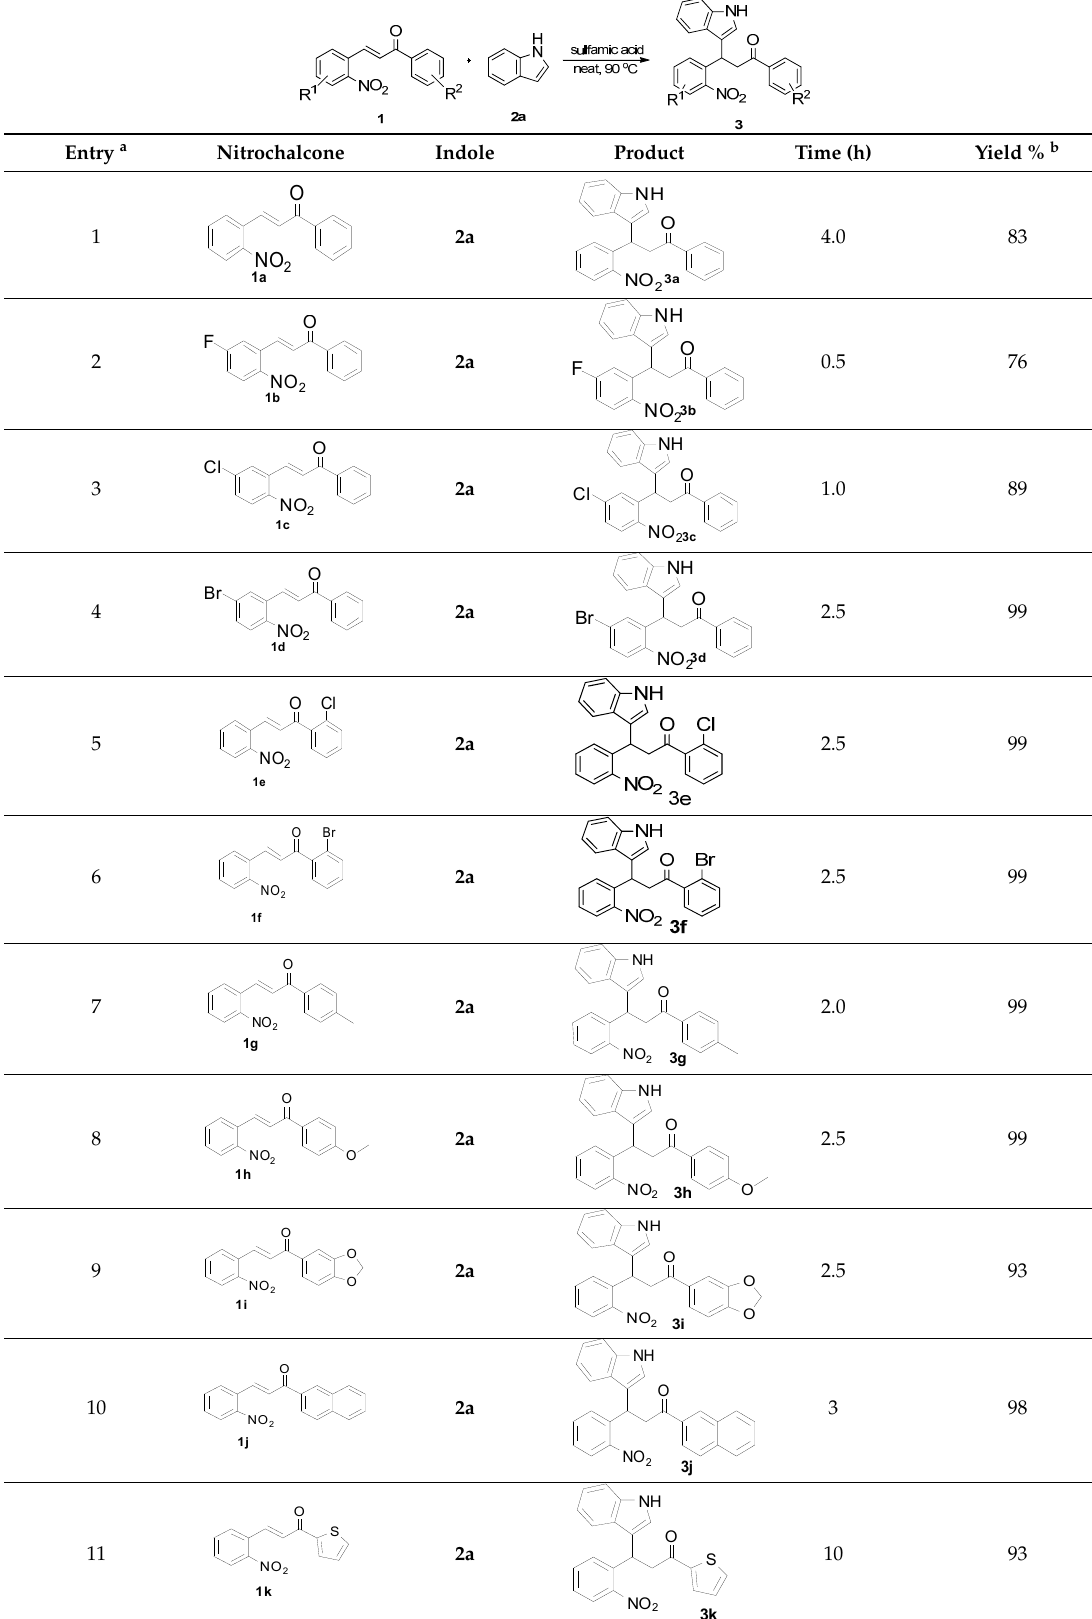
Entry a Entry a